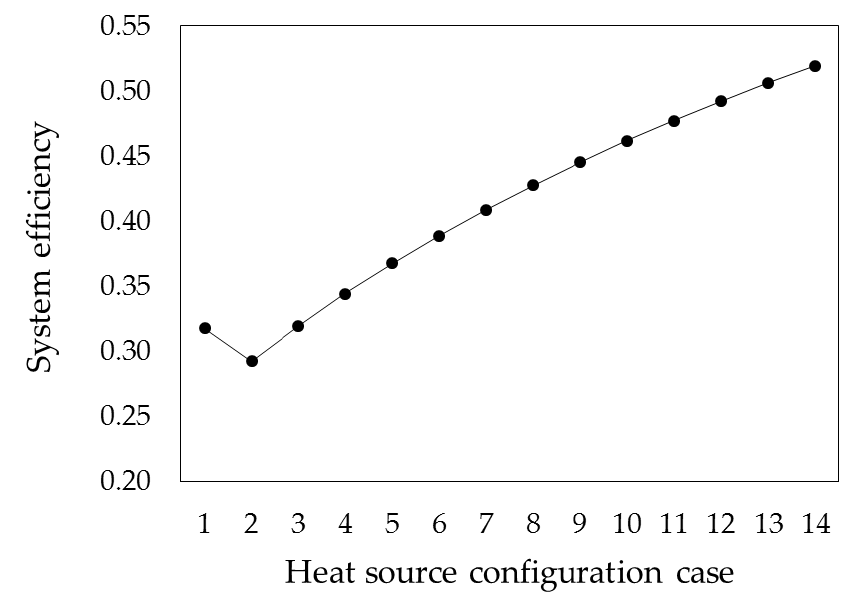
Figure 8. Energy efficiency of the system for the analyzed